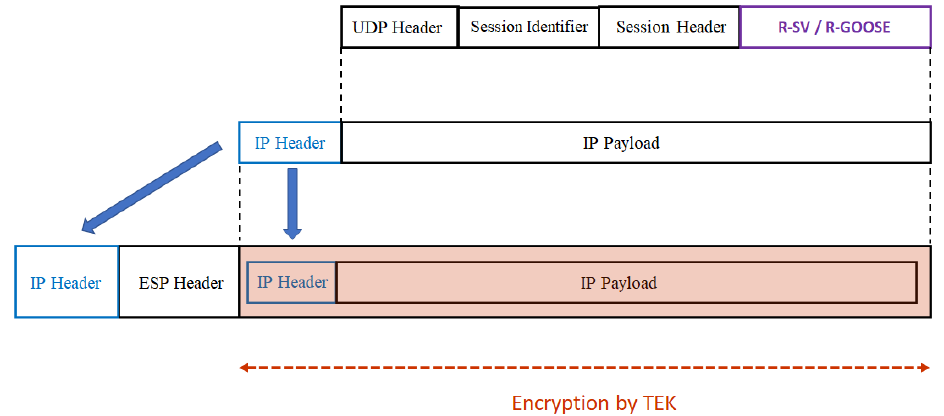
Figure 13. Securing R-SV/R-GOOSE messages by IPsec Tunnel Mode with Address Preservation.